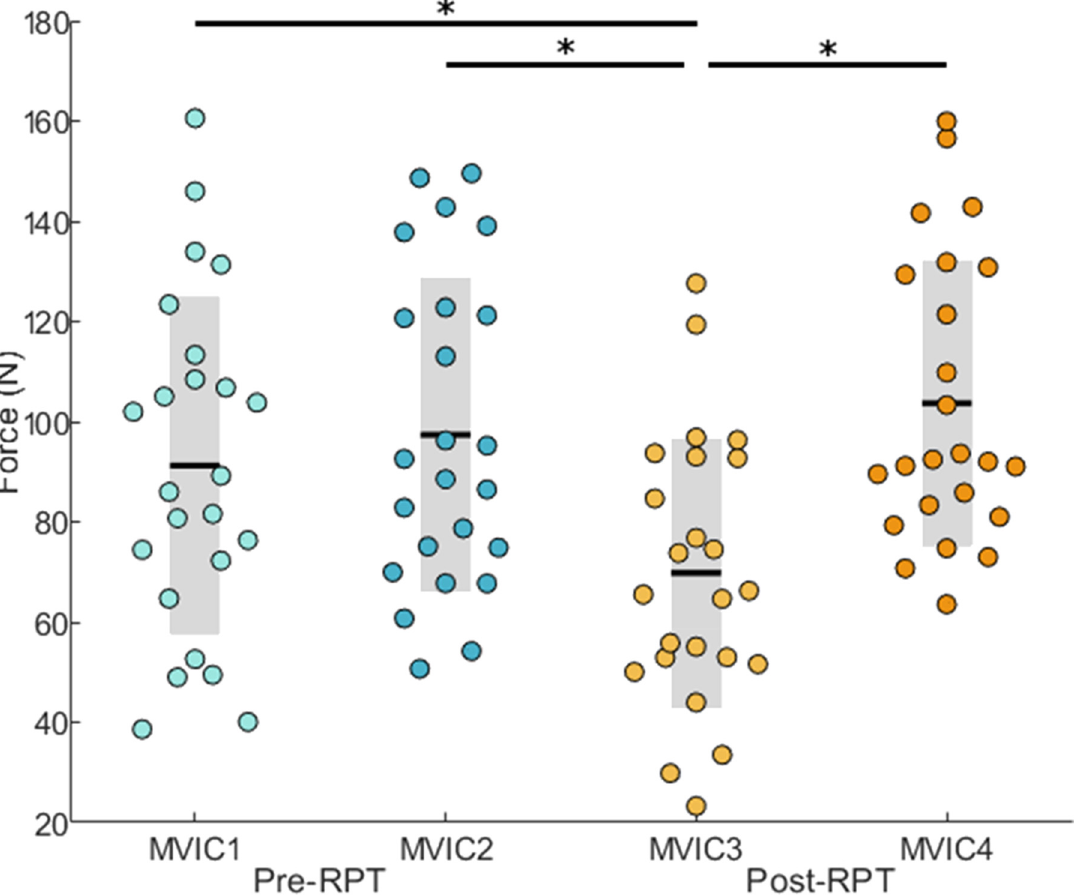
Figure 2. Force developed during MVIC trials. Dots represent each participants’ data. Black horizontal lines represent the participants means; grey bars represent standard deviations. Asterisks represent significant effects at p <